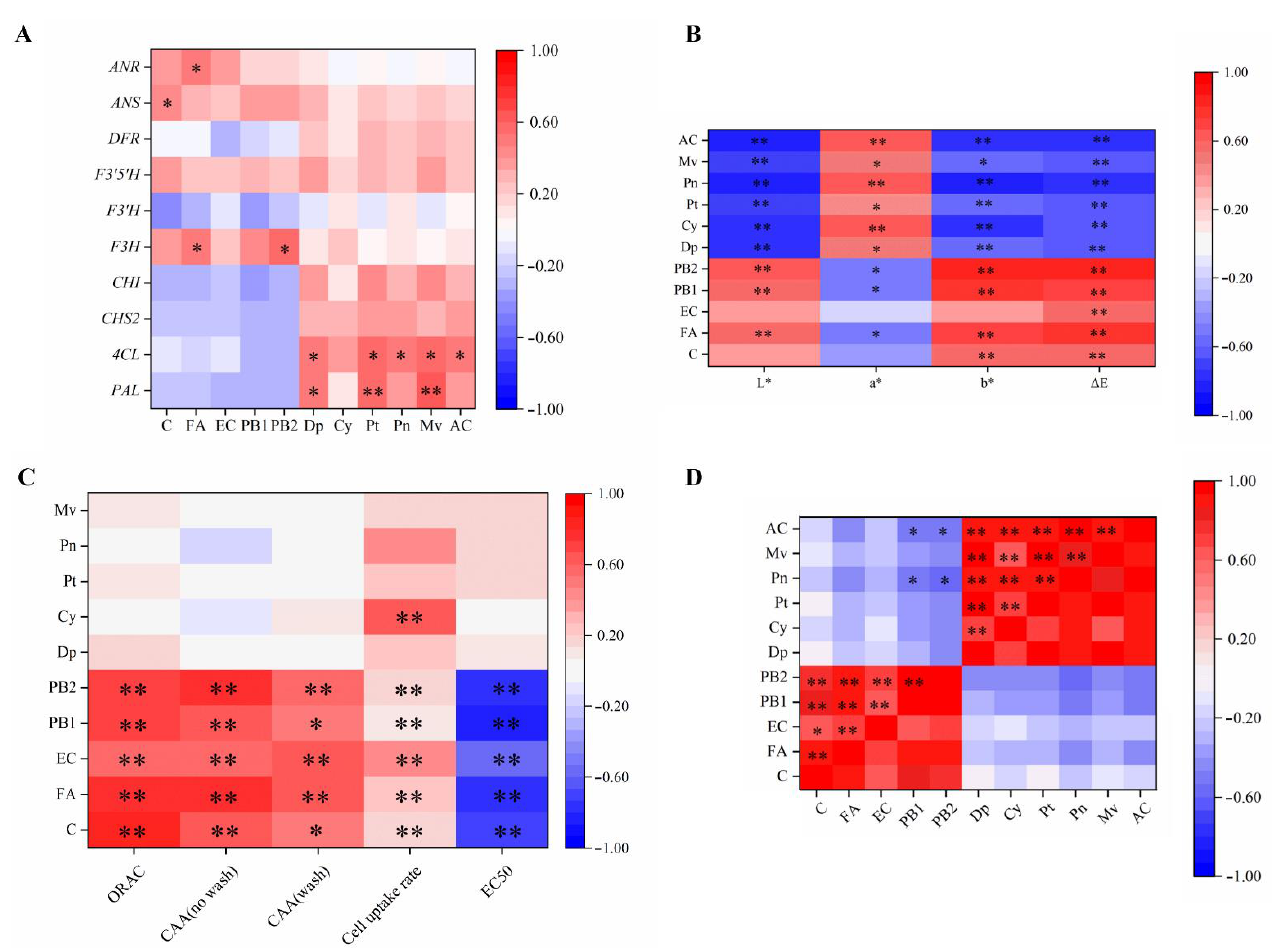
Figure 3. Pearson’s correlation analysis in grape berries during the five developmental stages in Urumqi and Turpan. ( A ) Gene expression and composition; ( B ) composition and color difference values; ( C ) composition and antioxidant quality; ( D ) composition. C, FA, EC, PB1, PB2, Dp, Cy, Pt, Pn, Mv, and AC stand for catechin, ferulic acid, epicatechin, procyanidin B1, procyanidin B2, delphinidin-3- O -glucoside, cyanidin-3- O -glucoside, petunidin-3- O -glucoside, peonidin-3- O -glucoside, mal-vidin-3- O -glucoside, and total anthocyanins, respectively. *, Significant at 5% probability levels; **, significant at 1% probability levels.